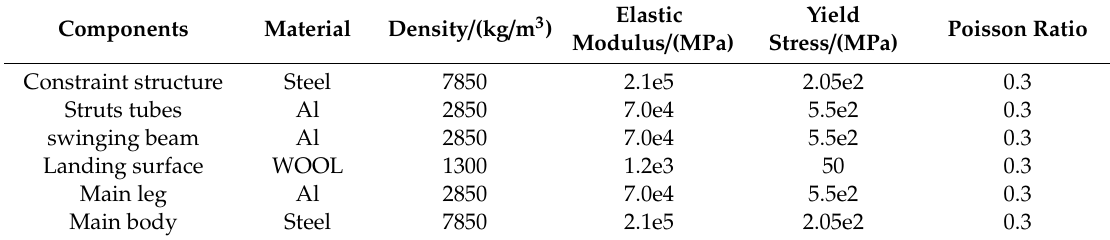
Table 5. Property parameters of stages and material.